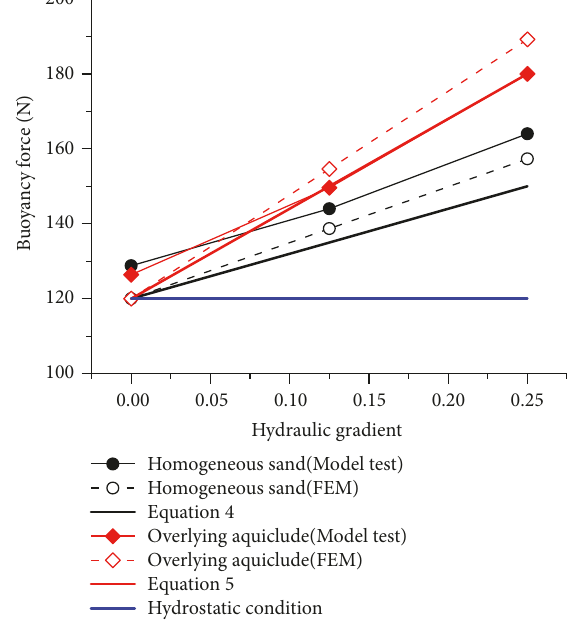
Figure 11: Comparison between measured buoyancy force values and finite element